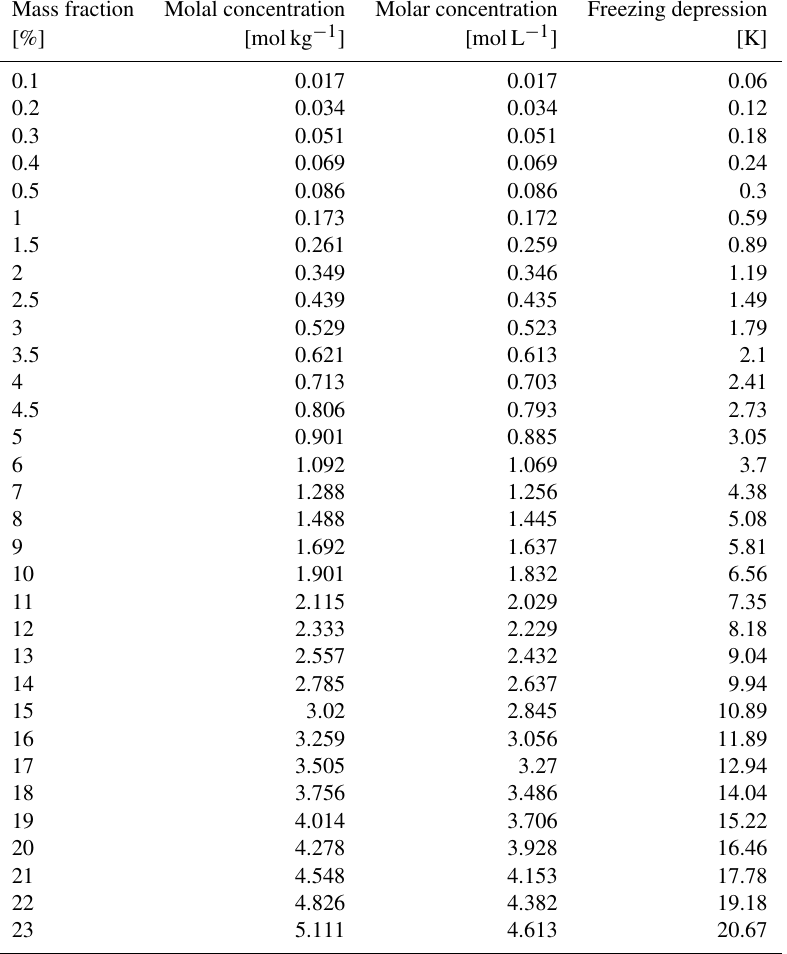
Table B1. Freezing-point depression data of NaCl (Rumble,